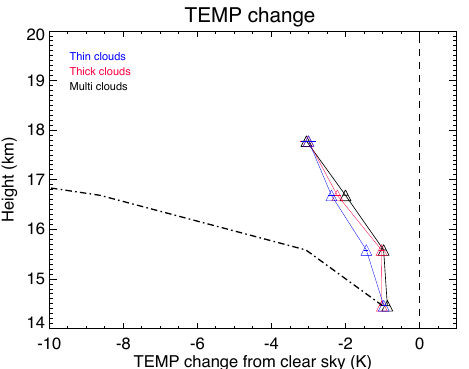
Fig. 9. Temperature anomalies near cloud top from zonal mean clear sky temperature. Dash-dot line shows idealized temperature anomalies without mixing with the environment when we assume that the LNB is 14.5 km.